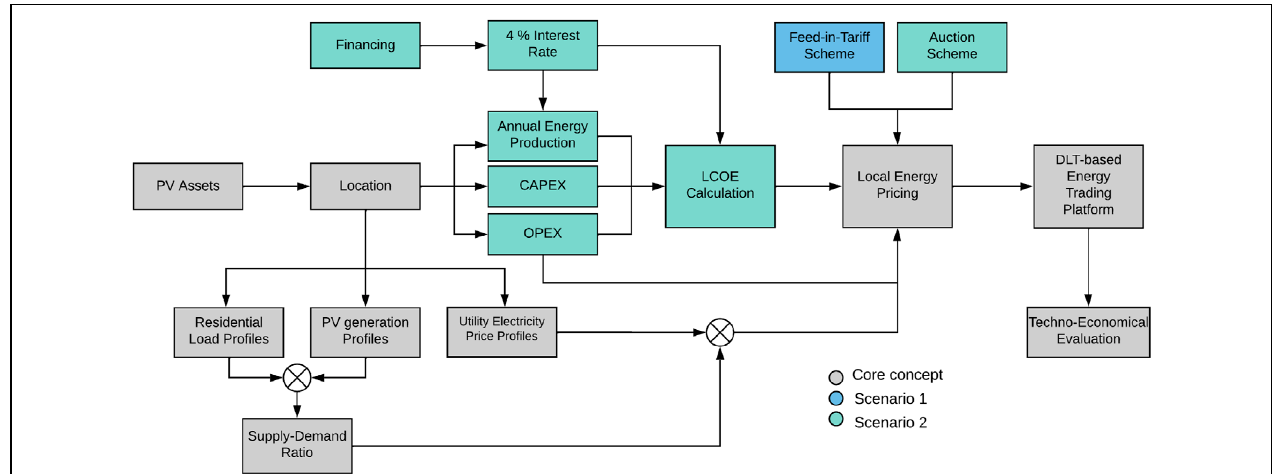
FIGURE 2 | Flowchart of overall pricing